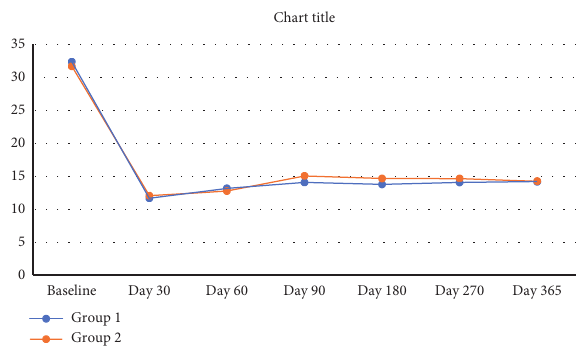
Figure 3: The mean diurnal IOP for all patients in both groups at the one year visit, with P values demonstrating no difference be- tween the two groups. X -axis represents the time intervals at which IOP was measured. Y -axis represents the intraocular pressure (IOP) at a given point in time.